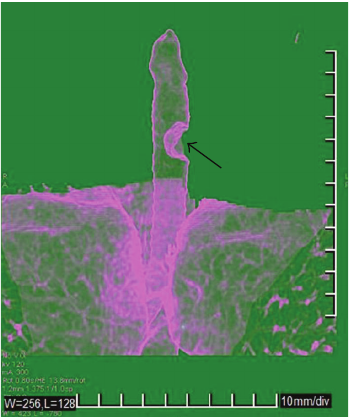
Figure 2: 64-year-old female with granular cell tumor of trachea. Coronal contrast-enhanced CT scan (16-slice Multidetector CT, GE Medical Systems, venous phase) obtained at the level of the aortic arch shows an eccentrical mass (white arrow) growing in the left side of trachea, occupying half of the tracheal lumen.